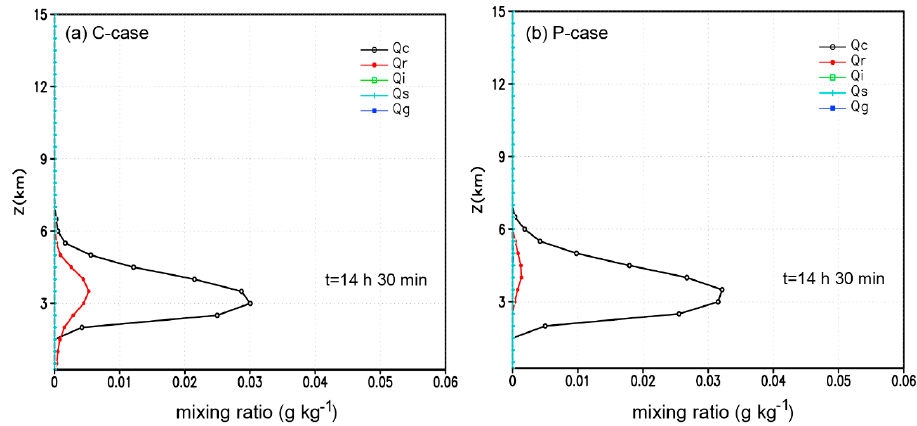
Figure 4. Vertical profiles of domain-averaged mixing ratios (g kg − 1 ) of hydrometeors for ( a ) C-case and ( b ) P-case at t = 14 h 30 min. The symbols Q c , Q r , Q i , Q s , and Q g represent the mixing ratios of cloud water, rain water, ice crystals, snow, and graupel, respectively.